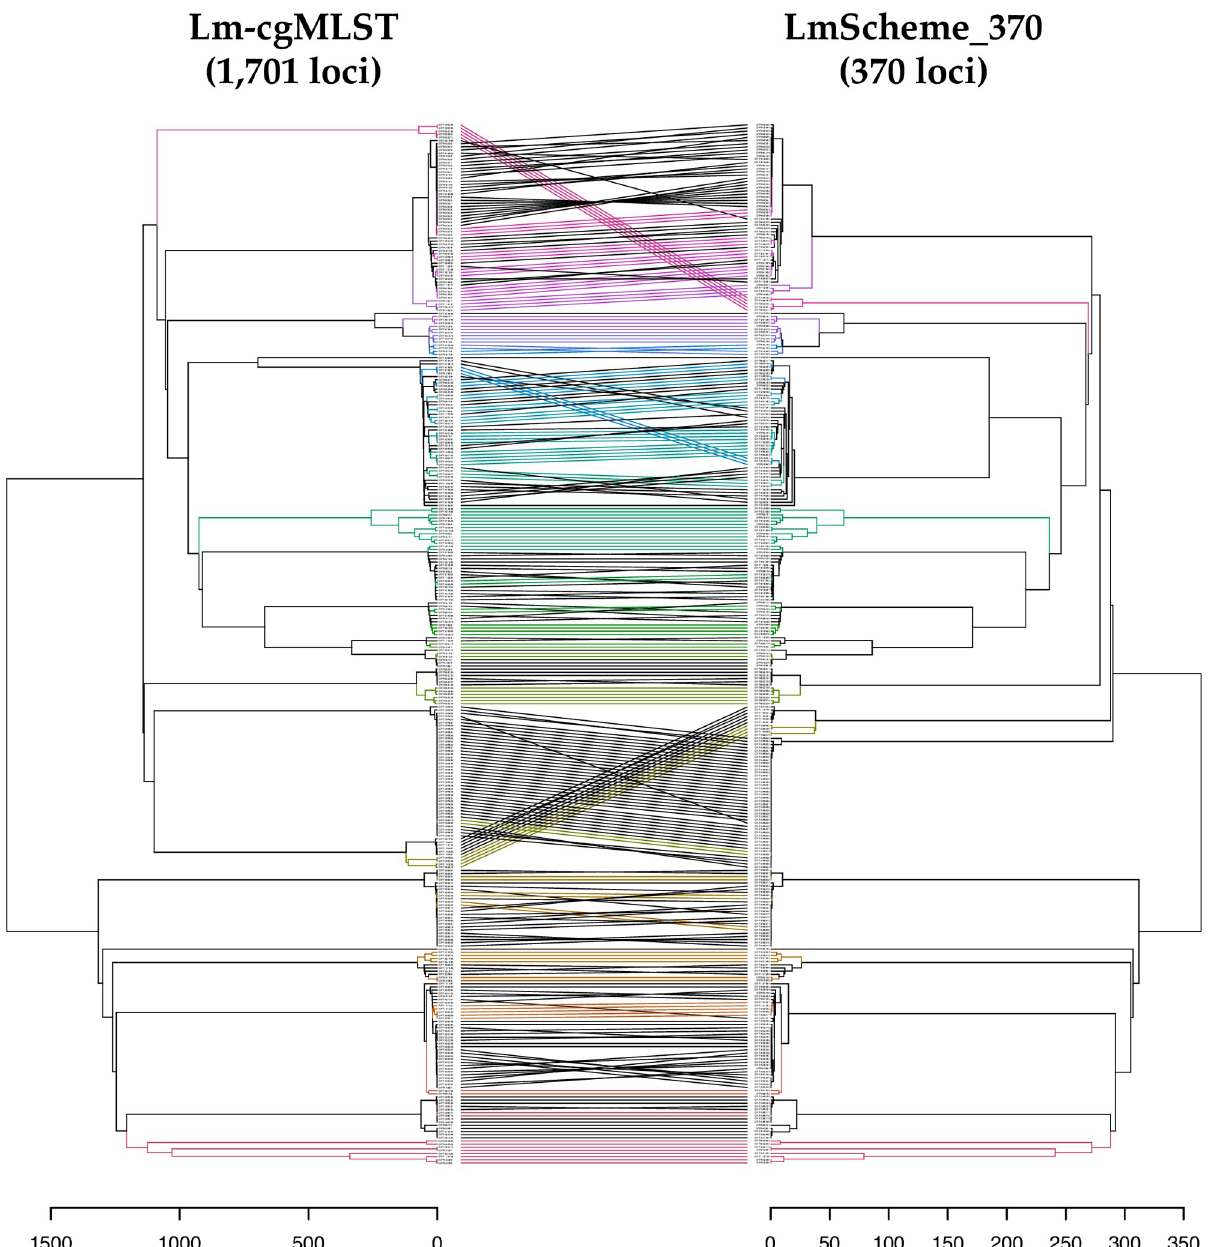
Fig 4. Tanglegram of dendrograms calculated based on Lm-cgMLST (1,701 loci) and LmScheme_370 allelic profiles from Set B (independent test set). Both allelic distance scales are displayed. The same isolate in each dendrogram is connected with a line; the colors have no meaning but are used for easier